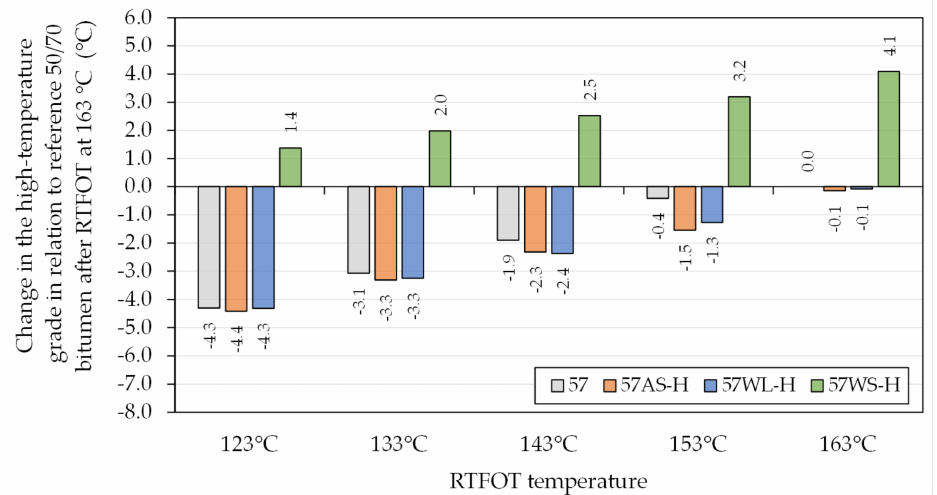
Figure 8. Change in the high-temperature grade of the investigated asphalt binders based on the 50/70-penetration bitumen due to RTFOT ageing in relation to the reference 50/70 bitumen after RTFOT at 163 ◦